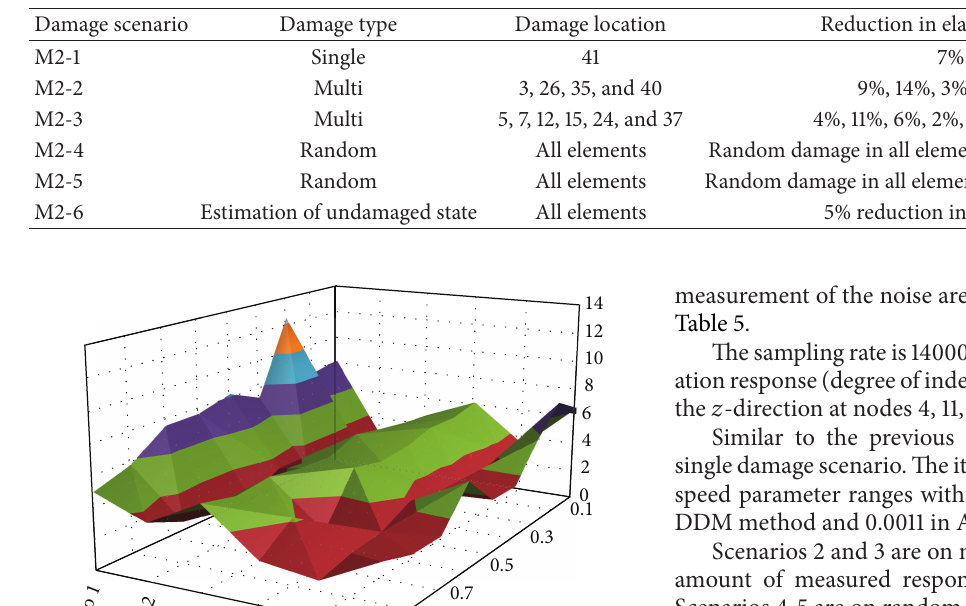
Table 5: Damage scenarios for grid model.